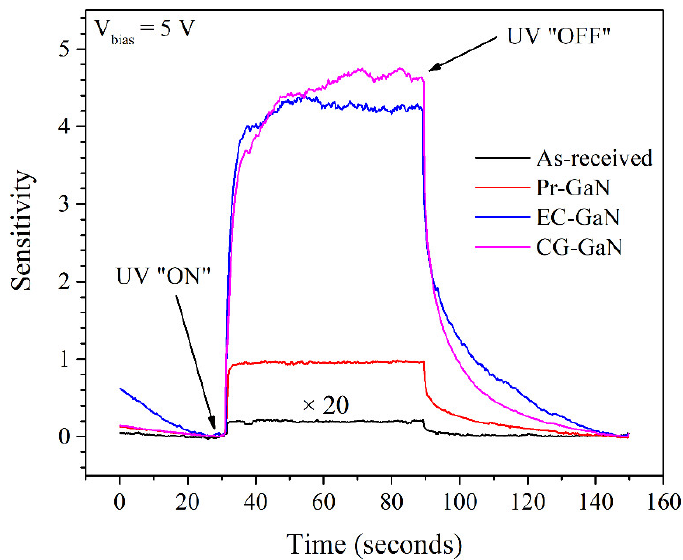
Figure 6. Sensitivity−transient profile of UV photodetectors. The sensitivity for the as−received UV photodetector was multiplied by 20 times for better clarity. The applied biased voltage used in this measurement was set to 5 V.